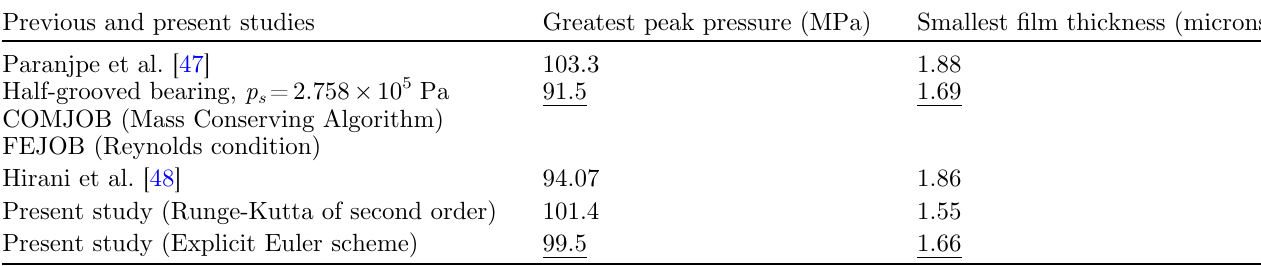
Table 3. Results for the Paranjpe ’ s gasoline engine crankshaft main bearing.